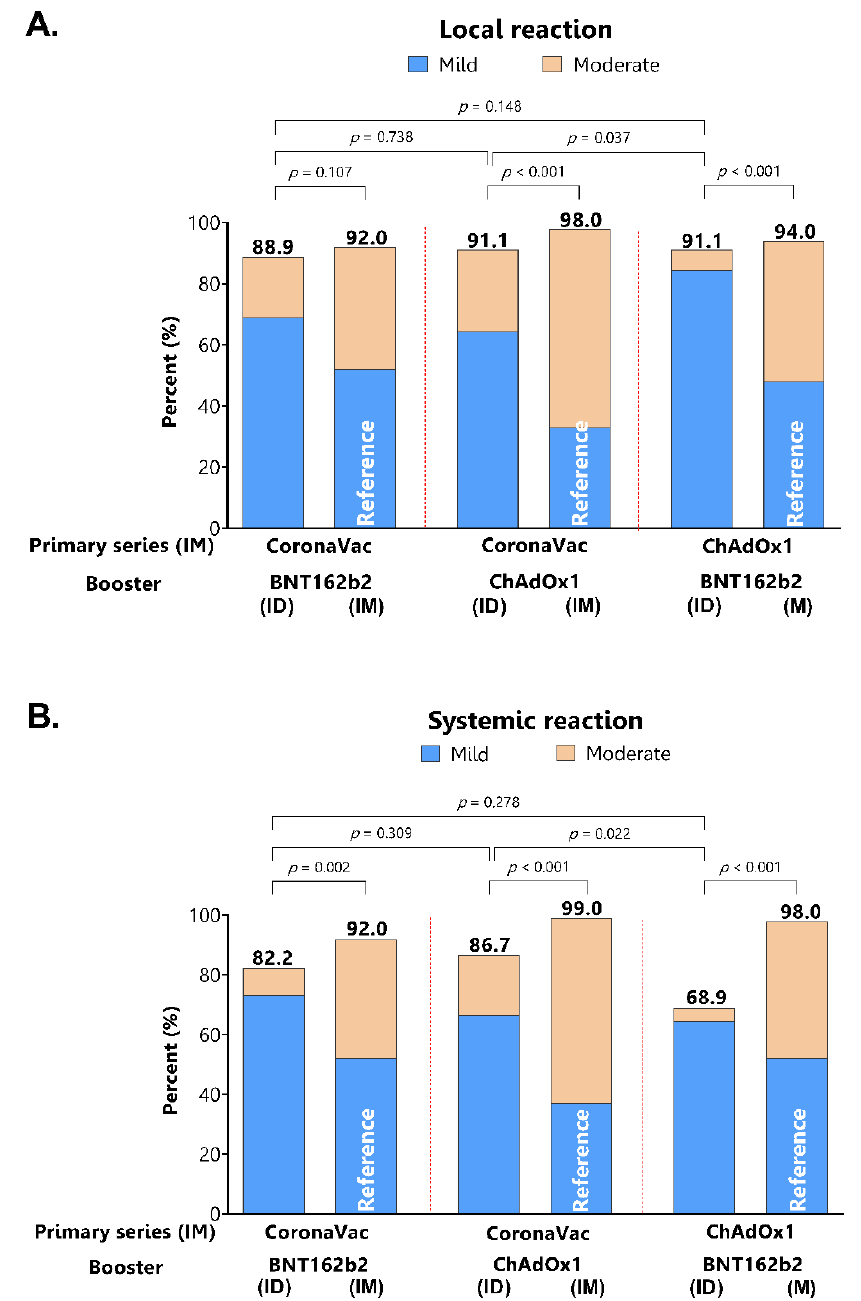
Figure 5. Self-reported adverse events following intradermal boosting consist of local injection site reaction (A) and systemic reaction (B). Intramuscular boosting of the similar vaccine regimens from the previous study [19] is included as a reference